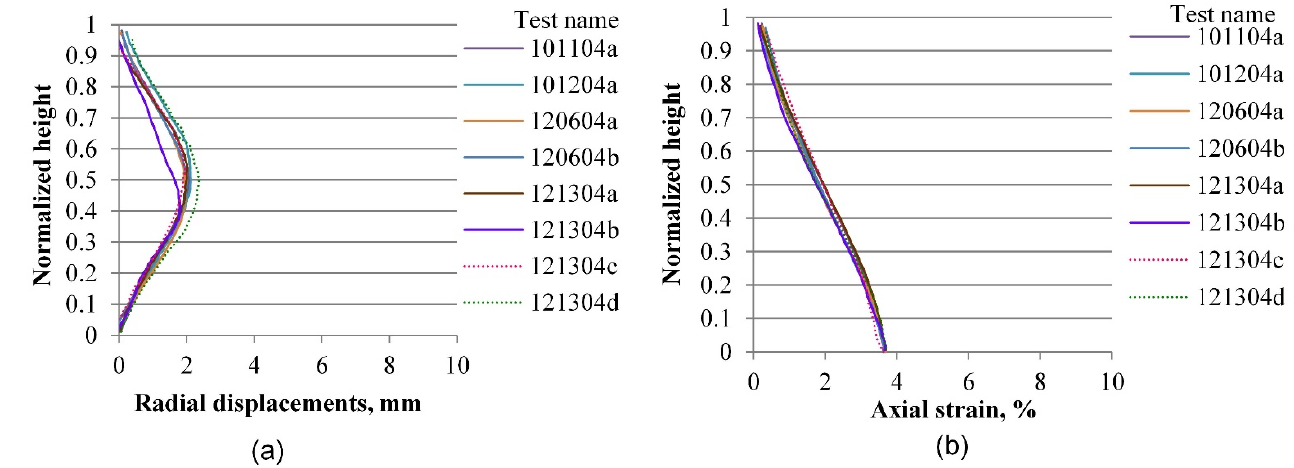
Figure 22. Vertical profiles of averaged displacements at 3.6% of the axial strain of sand specimens prepared by the dry pluviation method: radial displacements field ( a ) and vertical displacements field ( b ).